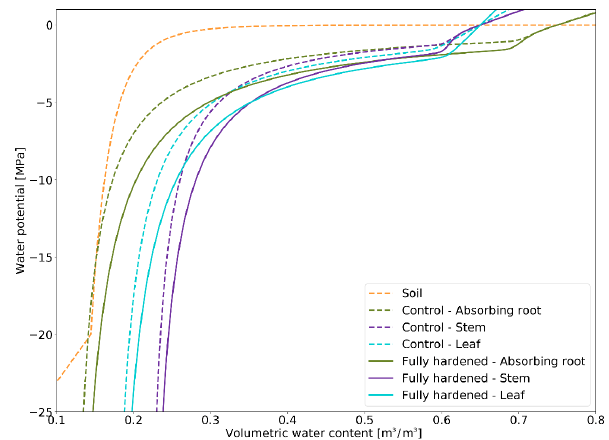
Figure 3. Pressure–volume curves for soil (orange) and plant com- partments. The PV curves used by the default CLM5-FATES-Hydro and non-hardened plants are the dashed lines, while the PV curves used by plants acclimated to − 70 ◦ C are the full